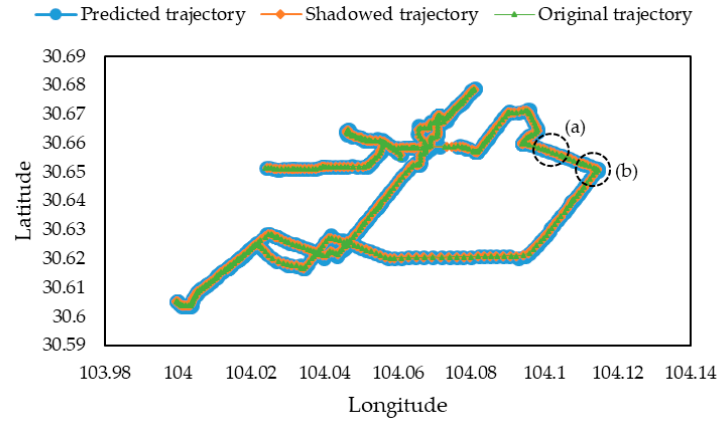
Figure 15. The original, shadowed, and predicted trajectories of the taxi for the testing set.